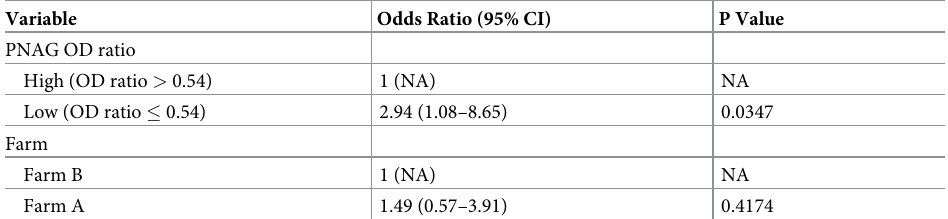
Odds ratios (and 95% CIs) estimated using logistic regression for the outcome of pneumonia attributed to R . equi among 116 foals transfused with β -(1 ! 6)-linked poly- N -acetyl-glucosamine hyperimmune plasma (PNAG HIP) at both Farm A and Farm B. A binary PNAG activity-level variable was created using the median value of PNAG optical density (OD) ratio for the group of foals was included in the model as well as a variable of farm to account for the potential effects of differences between farms in the method of